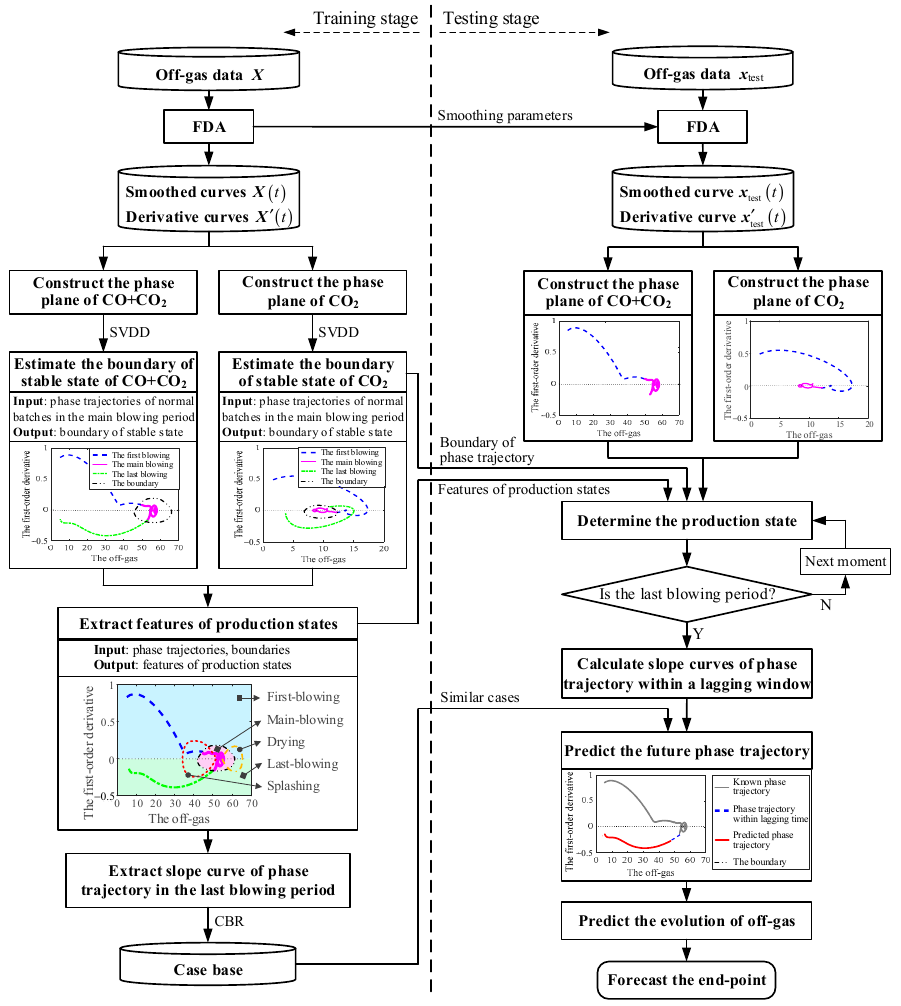
Figure 5. The schematic diagram of the proposed FDA-PP method.